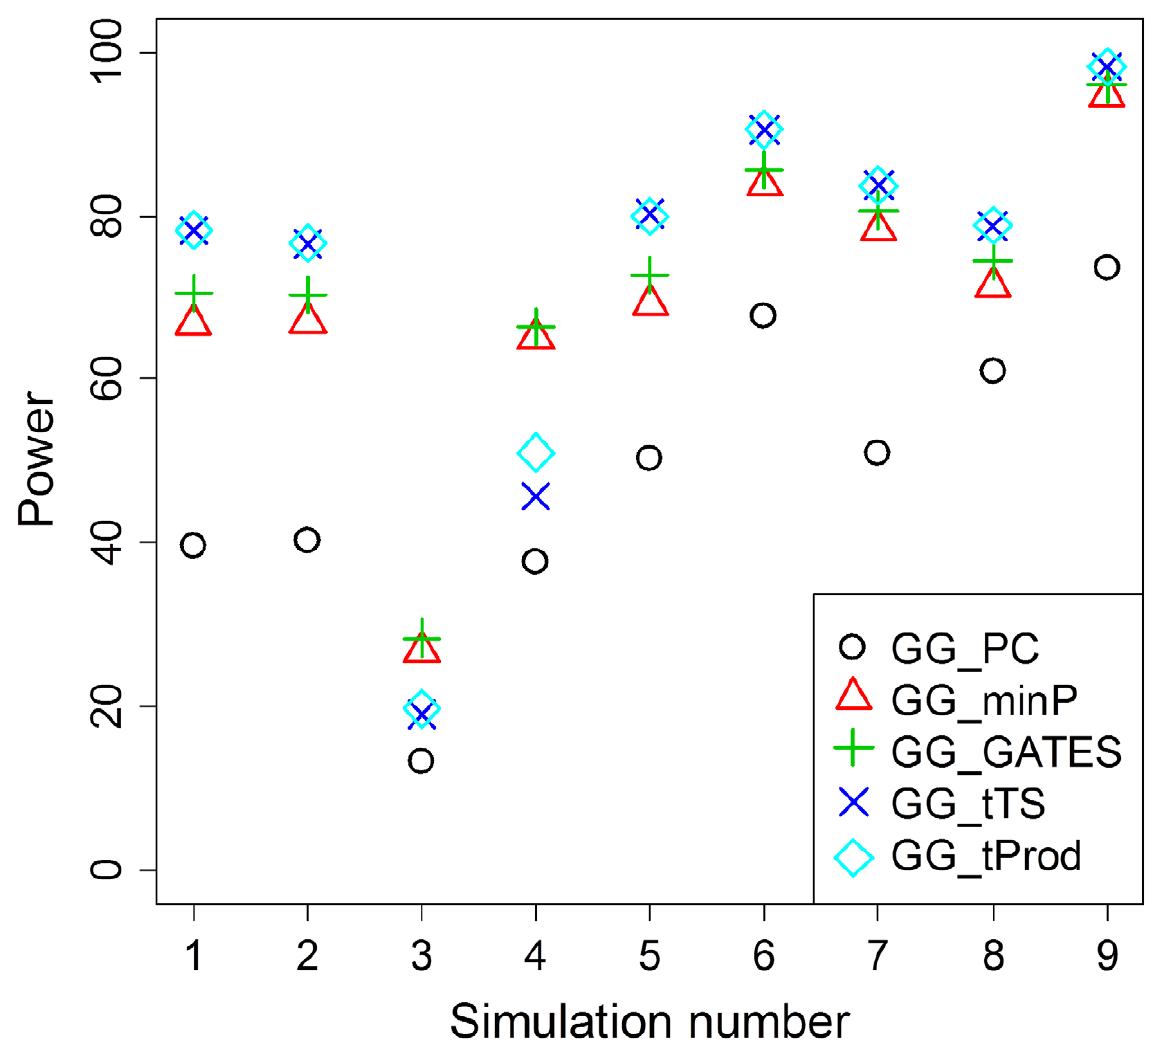
Figure 2. Average power of GGG tests summarized from Table 2. For each simulation scenario from Table 2, average power for each type of test is presented as an average across the different sample sizes ( n ) reported in Table 2. The method that collapses markers in each of the two genes, GG_PC, is least powerful in all simulation scenarios. Among the four GGG tests that combine P values, GG_minP and GG_GATES are more powerful only in simulation scenarios 3 and 4, which are the only cases that we simulated a single marker-by-marker interaction with both markers available for analysis (denoted by O-O in Table 2). GG_tTS and GG_tProd are most powerful in all other simulation scenarios.